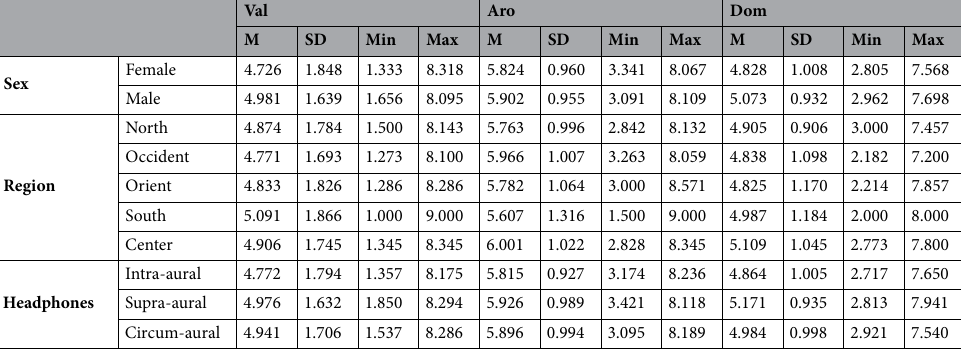
367 “Casino2”, sound no. 728 “Paper1”, sound no. 813 “Wedding”), arousal (min: sound no. 423 “Injury”; max: sound no. 275 “Scream”, sound no. 277 “FemScream3”, sound no. 285 “Attack2”, sound no. 290 “Fight1”, sound no. 310 “Crowd1”) and dominance (min: sound no 241 “MaleCough”; max: sound no. 802 “NativeSong”; sound no. 815 “RockNRoll”). Some sounds had the same greatest or lowest mean ratings in emotional dimensions. Descriptive statistics are presented in Table 2. Correlation analysis showed that north and center regions had the greatest correlation coefficient in valence (r = 0.969, p < 0.05) and dominance (r = 0.893, p < 0.05). Occident and center regions had the greatest positive correlation in arousal (r = 0.902, p < 0.05). The lowest correlation was observed between occident and south in valence (r = 0.766, p < 0.05), arousal (r = 0.463, p < 0.05), and between orient and south in dominance (r = 0.274, p < 0.05). Coefficients were above 0.5 for all remaining regions in valence (North–occident: r = 0.951. North–ori- ent: r = 0.943. North - south: r = 0.788. Occident–orient: r = 0.946. Occident–center: r = 0.955. Orient–south: r = 0.787. Orient–center: r = 0.955. South–center: r = 0.787. P < 0.001 for all cases) and arousal (North–occident: r = 0.835. North–orient: r = 0.751. North - south: r = 0.552. North–center: r = 0.897. Occident–orient: r = 0.675. Orient–south: r = 0.502. Orient–center: r = 0.724. South - center: r = 0.501. P < 0.001 for all cases). In domi- nance, correlation coefficients between some regions were below 0.5 (North - occident: r = 0.843. North–orient: r = 0.814. North–south: r = 0.336. Occident–orient: r = 0.806. Occident–south: r = 0.278. Occident–center: r = 0.867. Orient–center: r = 0.853. South - center: r = 0.321. P < 0.001 for all cases). MANOVA test indicated significant differences in arousal (F = 3.67, p < 0.01) but not in valence (F = 0.76, p = 0.550) and dominance (F = 1.96, p = 0.098). Multiple comparison showed evidence of statistical differences between south–center (T = − 3.31, p < 0.05), and south–occident (T = − 3.01, p < 0.05) regions, but not between the rest of the regions (North–center: T = − 2.00, p = 0.457. Occident–center: T = − 0.30, p = 1.000. Orient–center: T = − 1.84, p = 0.664. Occident–north: T = 1.70, p = 0.886. Orient - north: T = 0.16, p = 1.000. South–north: T = − 1.31, p = 1.000. Orient–occident: T = − 1.54, p = 1.000. South–orient: T = − 1.47, 1.000). Type of headphones. The following number of ratings indicate the participants from each headphone group considered to calculate the mean rating of the 167 sounds: (1) intra-aural = 143; (2); supra-aural = 54; and (3) circum-aural = 132. Figure 4c shows the mean ratings of Mexican participants divided in headphone type. Most data outliers correspond to the supra-aural group. In Table 2, intra-aural group had the lowest ratings in valence (sound no. 279 “Attack1”) and dominance (sound no. 424 “CarWreck”), and the highest in arousal (sound no. 275 “Scream”). Supra-aural had the highest ratings in valence (sound no. 815 “RockNRoll”, sound no. 820 “FunkMusic”) and dominance (sound no. 815 “RockNRoll”). Finally, circum-aural had the lowest rating in arousal (sound no. 262 “Yawn”). Only supra-aural group had two sounds with the same greatest valence rating. Correlation coefficients showed that circum-aural and intra-aural groups had the greatest correlation coef- ficients in valence (r = 0.979, p < 0.05), arousal (r = 0.909, p < 0.001) and dominance (r = 0.902, p < 0.001). Supra-aural and intra-aural had the lowest coefficients in valence (r = 0.950, p < 0.001), arousal (r = 0.880, p < 0.001) and dominance (r = 0.778, p < 0.001). Coefficients were above 0.7 in supra-aural and circum-aural groups in valence (r = 0.962, p < 0,001), arousal (r = 0.892, p < 0.001), and dominance (r = 0.827, p < 0.001). MANOVA test indicated significant differences in dominance (F = 4.17, p < 0.05), but not in valence (F = 0.68, p = 0.507) and arousal (F = 0.59, p = 0.555). Multiple comparison showed evidence of statistical differ- ences between intra-aural and supra-aural groups (T = 2.86, p < 0.05). Significant differences were not observed between intra-aural–circum-aural (T = − 1.11, p = 0.802) and supra-aural–circum-aural (T = 1.75, p = 0.241). Additional sounds. The following number of ratings indicate the participants considered to calculate the mean rating of the seven additional sounds: (1) Pop = 107; (2) Banda = 107; (3) Electronic = 107; (4) Cumbia = 119; (5) Reggaeton = 104; (6) Pink noise = 106; and (7) White noise = 107. Figure 5 shows the distribution of additional sounds in the three-dimensional space of emotions. Cumbia was the sound with the highest valence (Valence: M = 8.550, SD = 0.938. Arousal: 7.193, SD = 2.154. Dominance: M = 7.303, SD = 2.062), and electronic with highest arousal and dominance (Valence: M = 8.346, SD = 1.166. Arousal: 7.467, SD = 1.717. Dominance: M